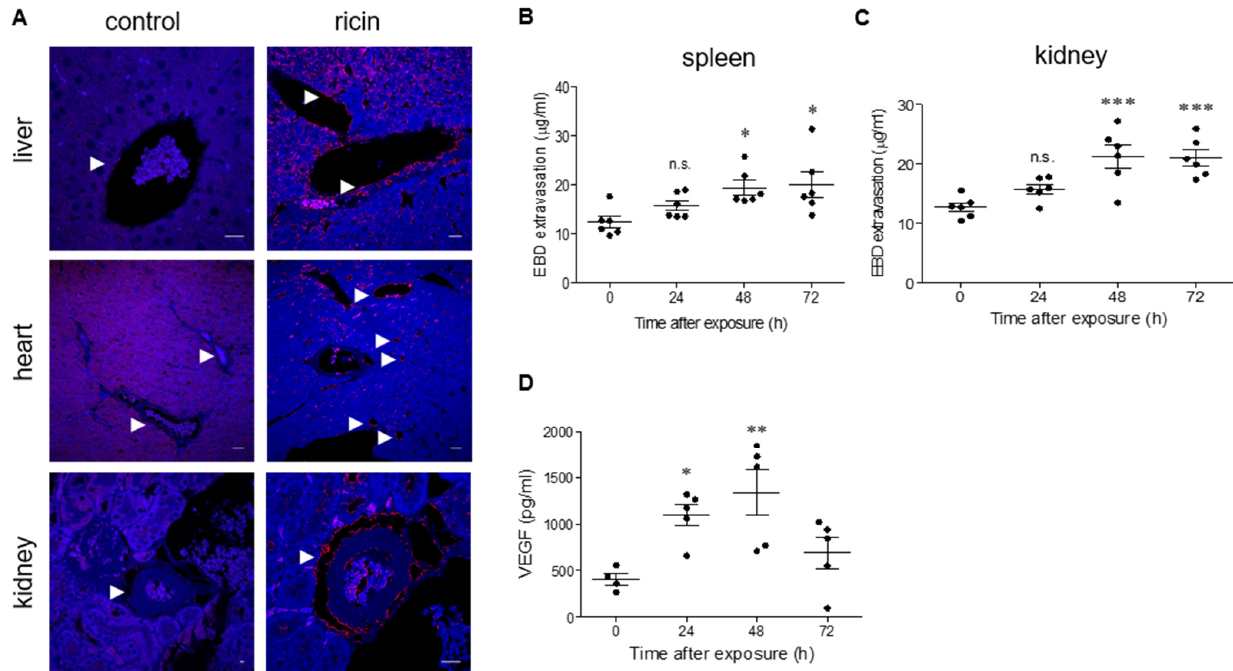
Figure 1. Ricin binding and organ hyperpermeability in ricin-intoxicated mice. ( A ) Immunofluorescence (red) of liver, heart and kidney sections before (control) or 30 min after incubation with ricin (5 µg/mL). The arrows indicate blood vessels and ricin binding. Nuclei stained by DAPI appear in blue. Scale bar: 20 µm (representative sections of n = 3 mice/group are shown). EBD in the spleen ( B ) and kidneys ( C ) following ricin intoxication. Control (0 h) or ricin-intoxicated mice (2LD 50 i.m., 18 µg ricin/kg body weight) were intravenously injected with 50 mg/kg EBD at the indicated time points and tissues were harvested 1 h later and monitored for EBD content. Each dot represents an individual mouse. ( D ) Circulating VEGF levels were determined in the serum samples from non-intoxicated (0 h) and ricin-intoxicated mice at the indicated time points. Each dot represents an individual mouse. In B–D, the results are depicted as means ± SEM. Statistical analyses were performed by one-way ANOVA followed by Dunnett’s post hoc test. * p < 0.05; ** p < 0.01; *** p < 0.001; n.s., not significant.